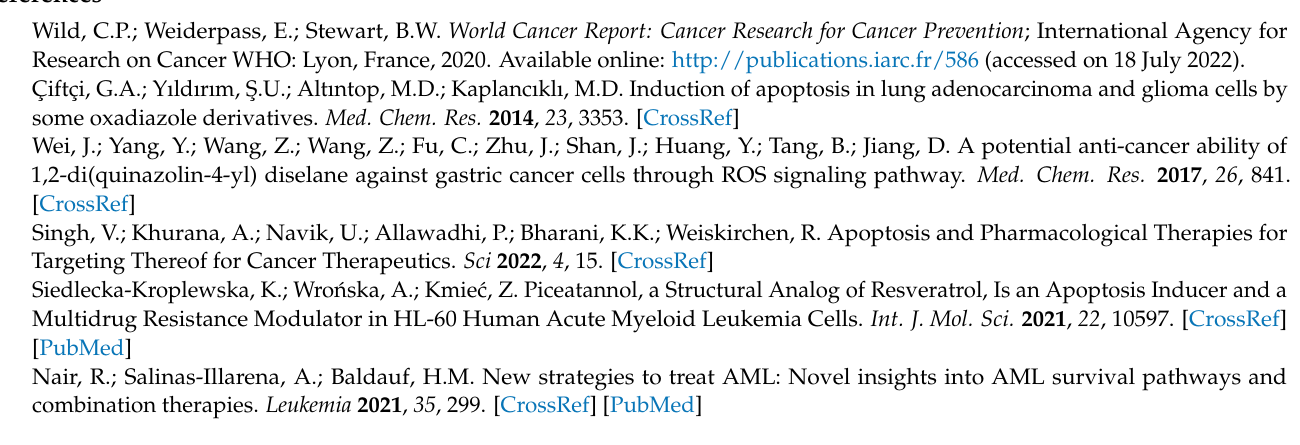
COSY of compound ( 8a ); Figure S13: HMBC of compound ( 8a ); Figure S14: HSQC of compound ( 8a ); Figure S15: 1 H NMR of compound (8b); Figure S16: 13 C NMR of compound ( 8b ); Figure S17: 1 H NMR of compound ( 8c ); Figure S18: 13 C NMR of compound ( 8c